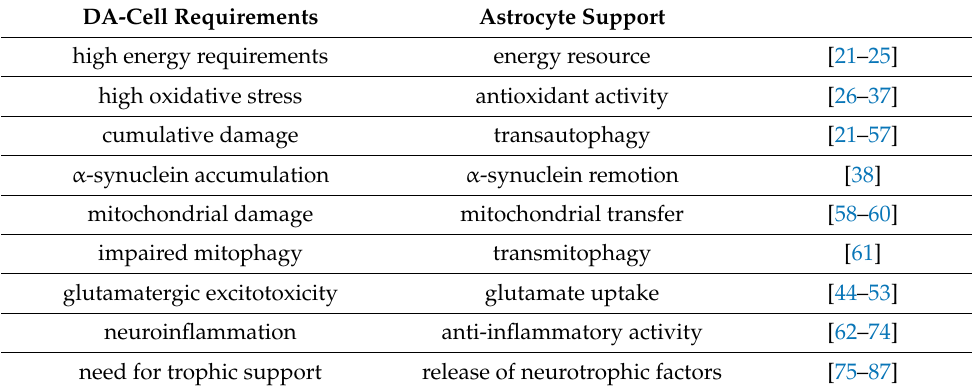
Table 1. Acting on the different stages of the PD